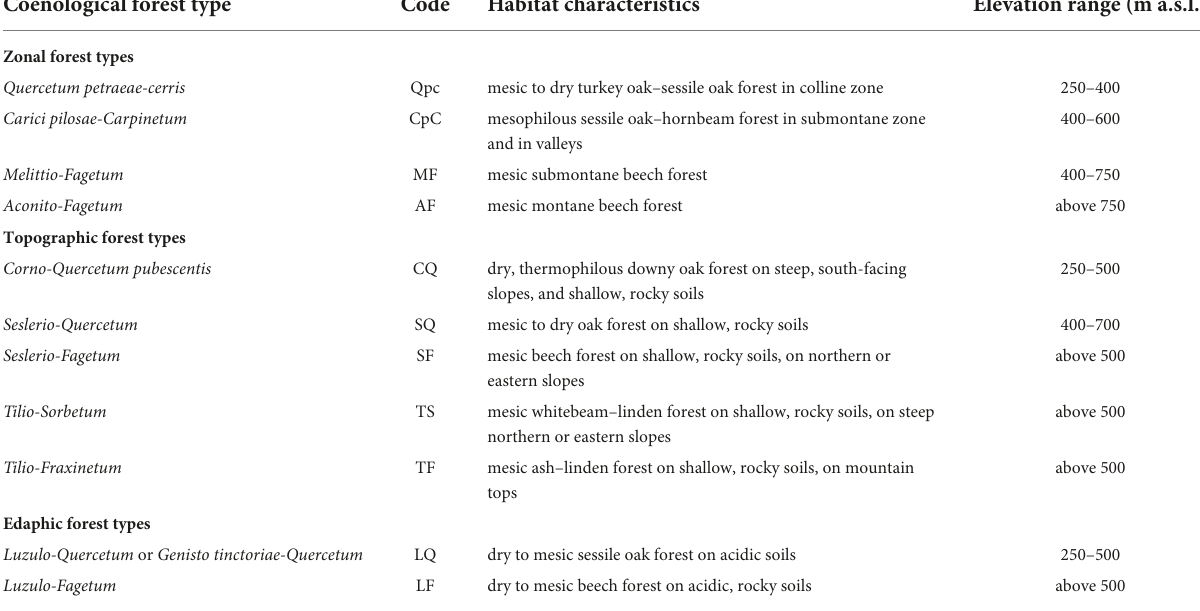
TABLE 1 Forest types included in this study with the main habitat characteristics and soil sampling